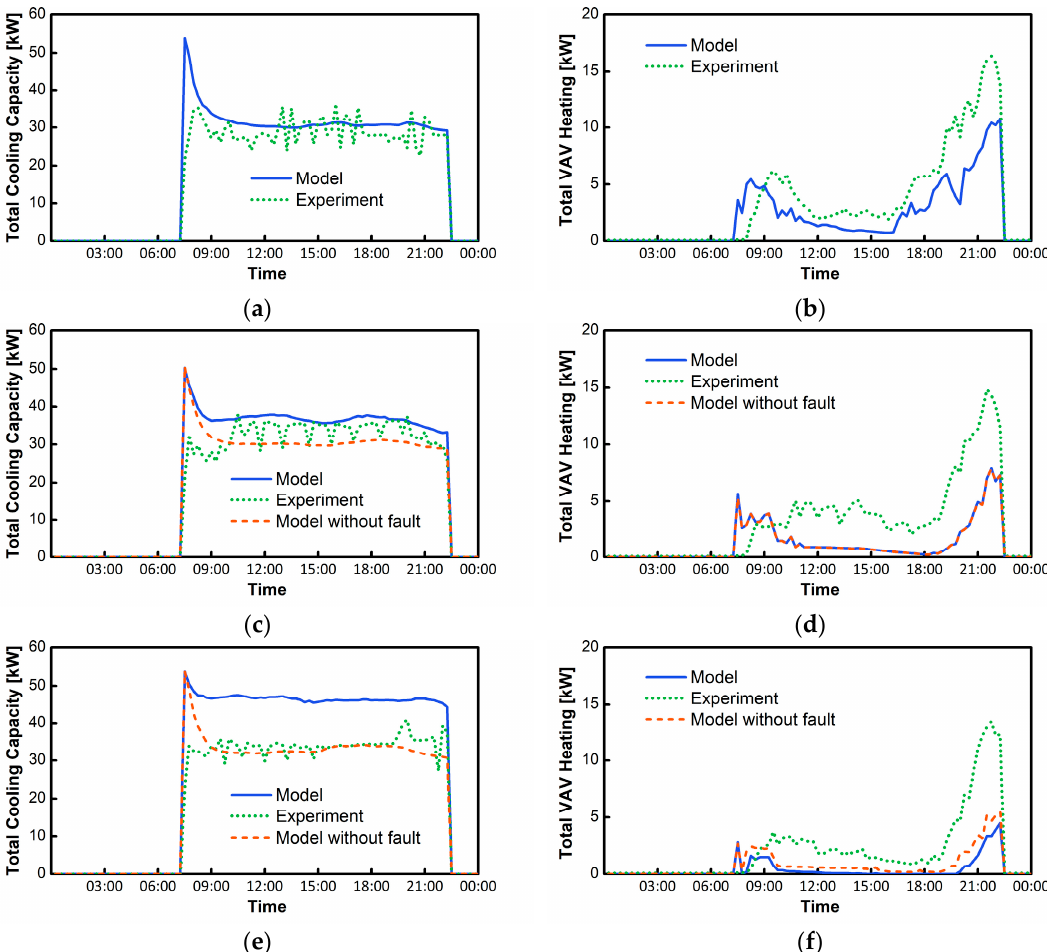
Figure 16. Total heating and cooling energy consumptions of baseline and faulted scenarios: Return air duct leakage. ( a ) baseline: total cooling capacity; ( b ) baseline: heating energy consumption; ( c ) +15% leak in return air duct: total cooling capacity; ( d ) +15% leak in return air duct: heating energy